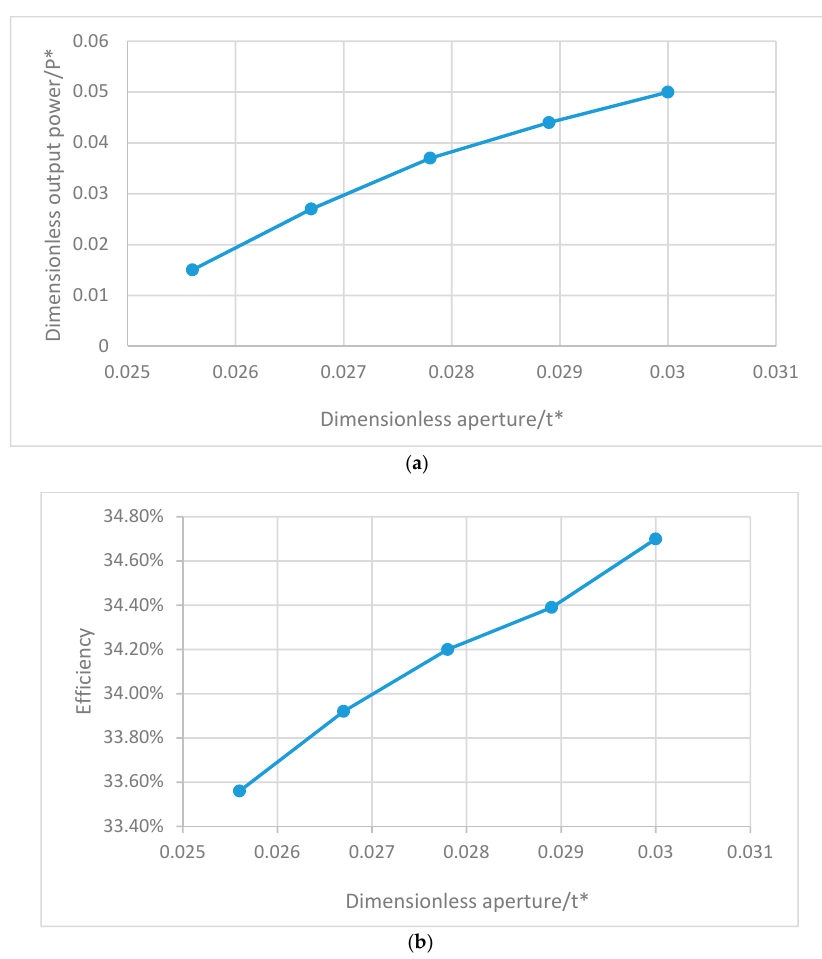
Figure 10. Relationships of dimensionless output power, efficiency and the aperture of the orifice of the hydraulic chamber. ( a ) Output power trend curve influenced by the aperture of the orifice of the hydraulic chamber; ( b ) Efficiency trend curve influenced by the aperture of the orifice of the hydraulic chamber.